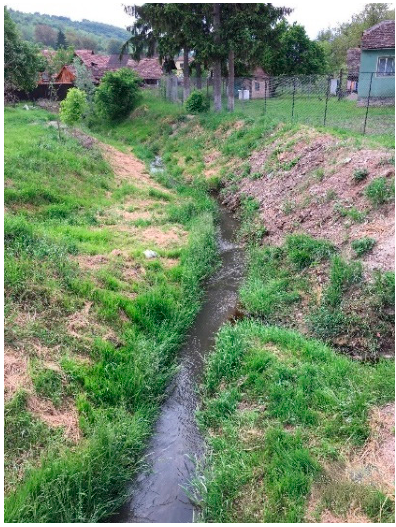
Figure 12. M ă lâncrav River non-refuge sector. Figure 12. M ă l â ncrav River non-refuge